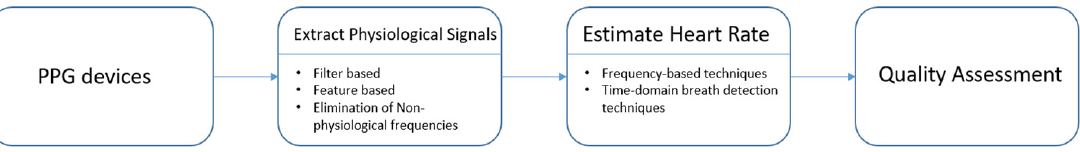
Figure 1. PPG signal processing framework.